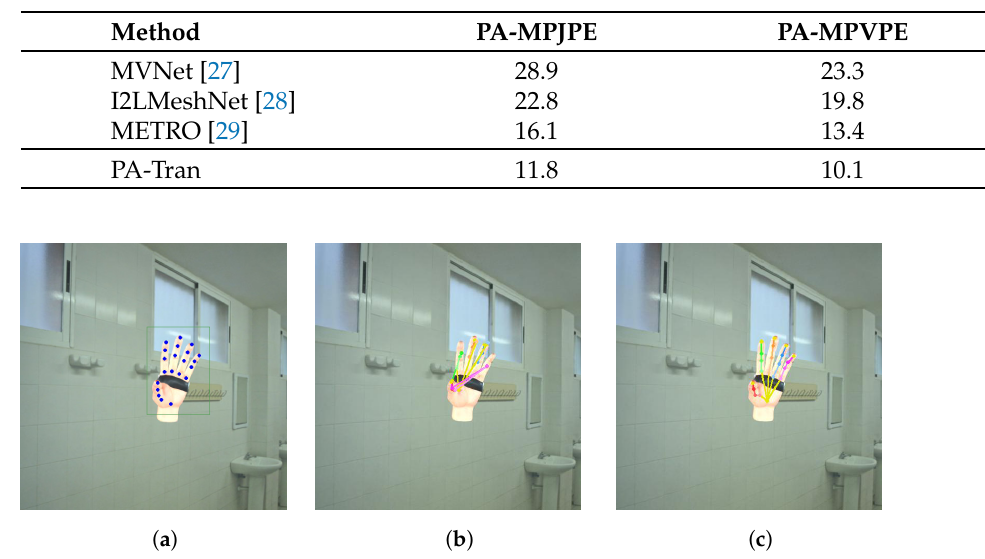
Figure 8. Qualititive result on APDM-Hand dataset: ( a ) Ground truth; ( b ) METRO; ( c )